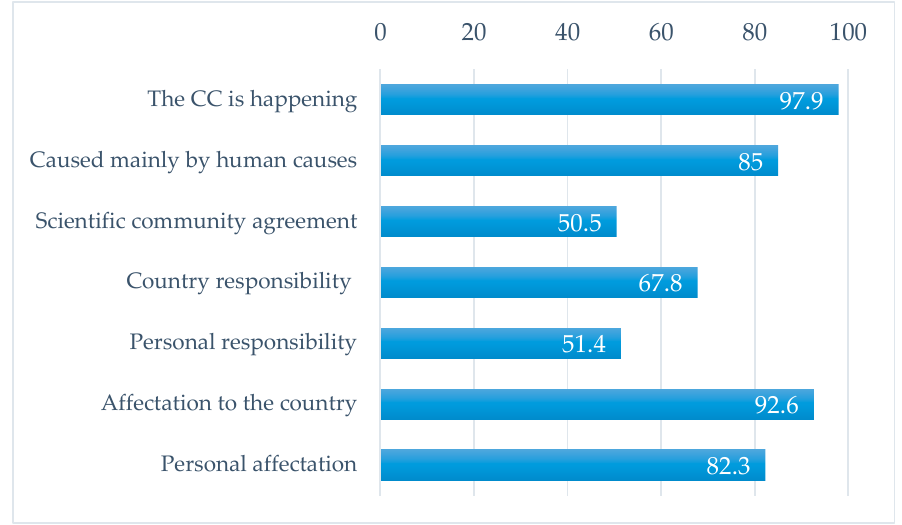
Figure 5. General opinion questions on CC.